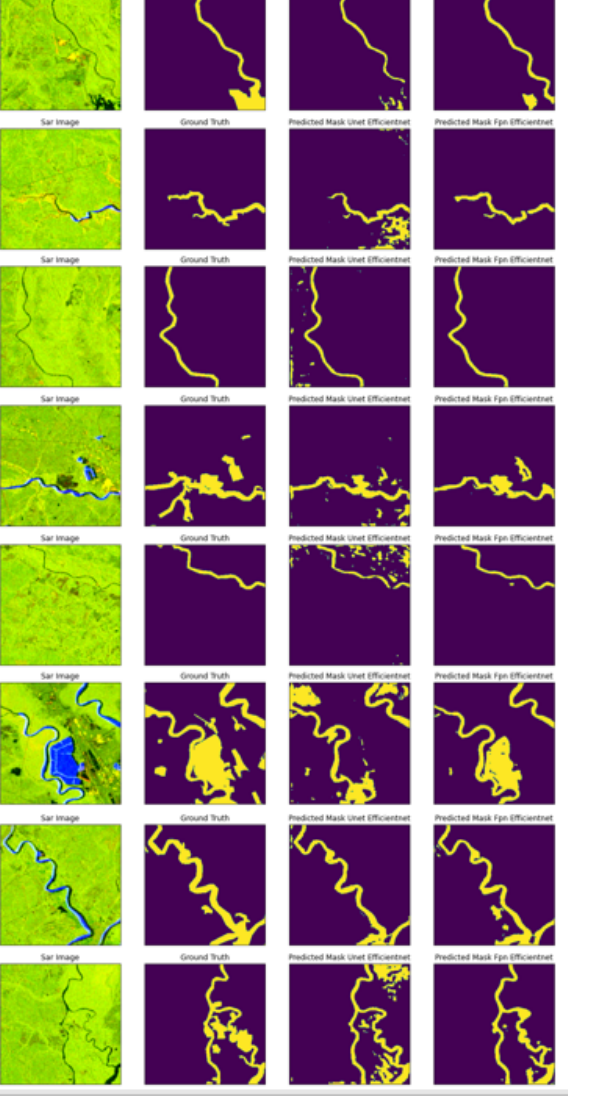
Figure 8. Figure showing the SAR composite image, the corresponding ground truth and the prediction results for both the UNet and the FPN models for the test dataset from